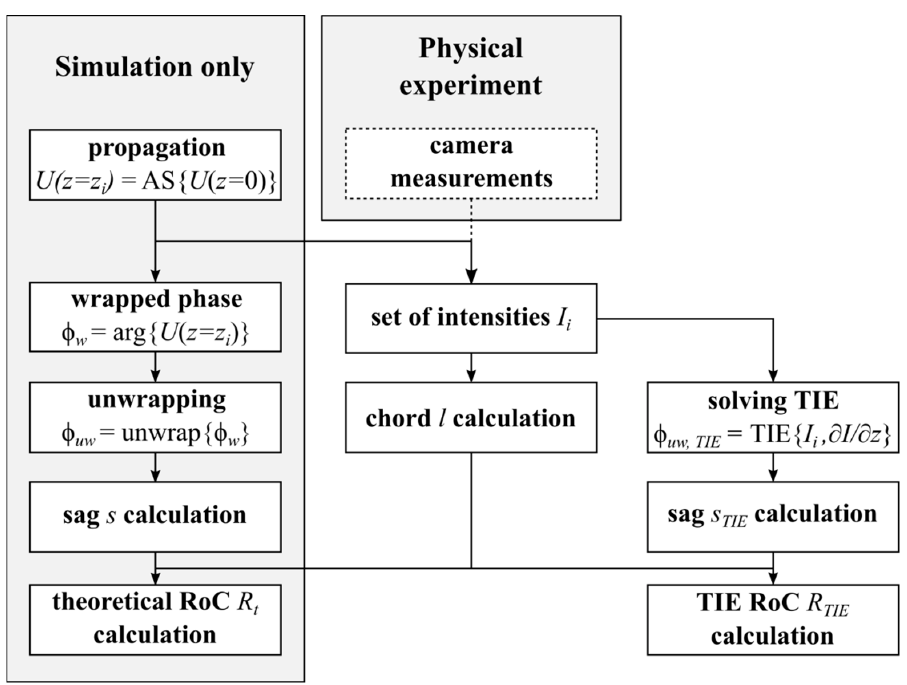
Figure 2. Flowchart with the steps of the modeling process. AS – angular spectrum method; TIE – transport-of-intensity equation; RoC – radius of curvature.